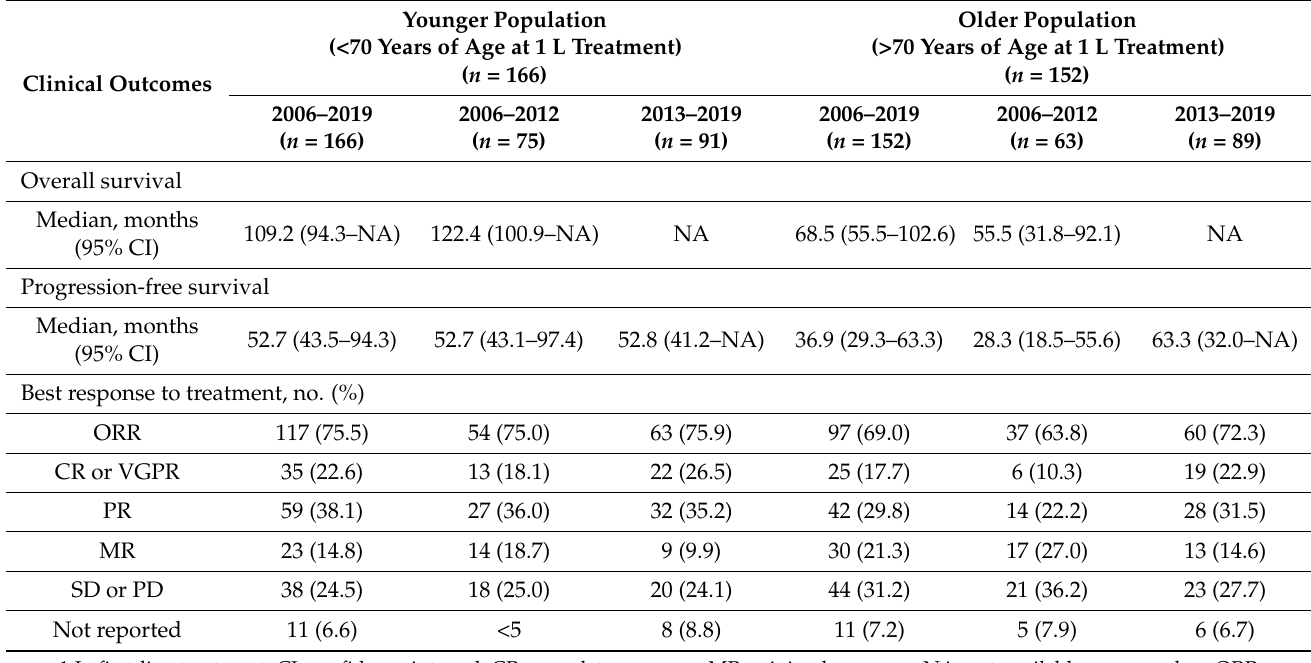
Table 5. Outcomes in veterans receiving treatment for Waldenström macroglobulinemia in VA from 2006 to 2019. Younger Clinical Outcomes